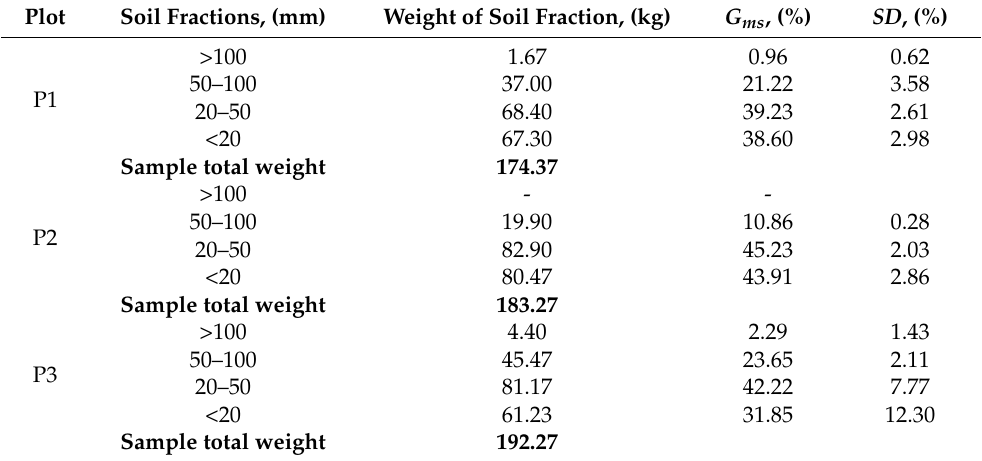
Table 3. Degree of soil